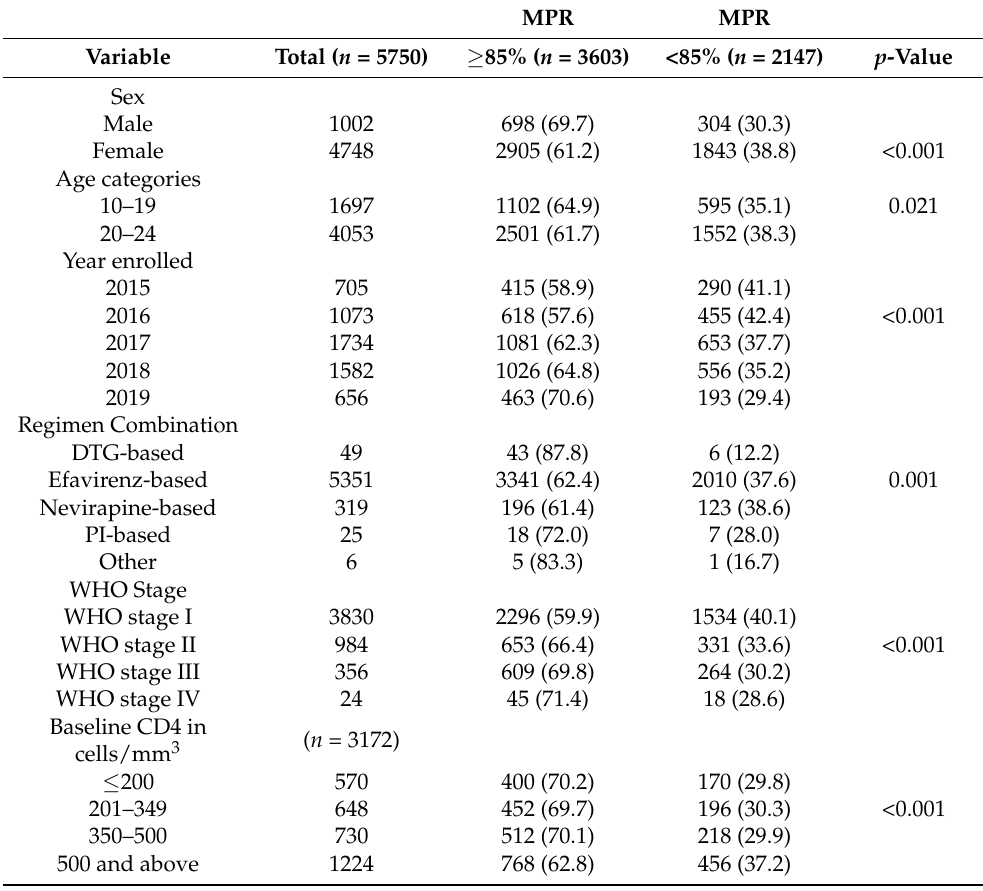
Table 1. Demographic and clinical characteristics of the study